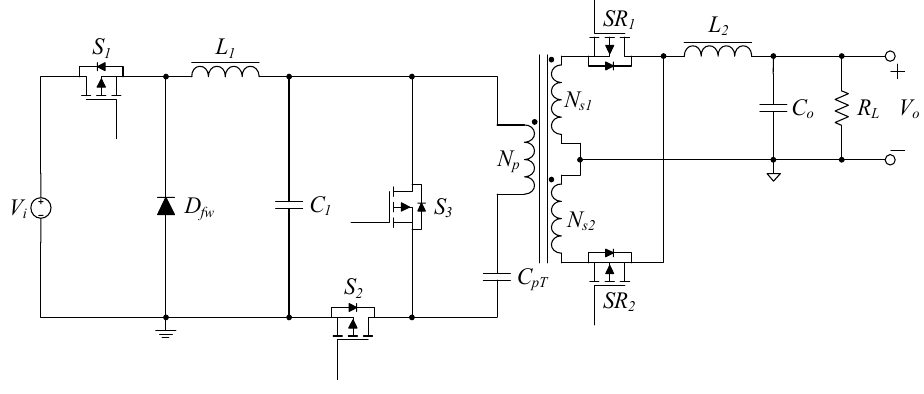
Figure 2. The topology of the proposed converter.